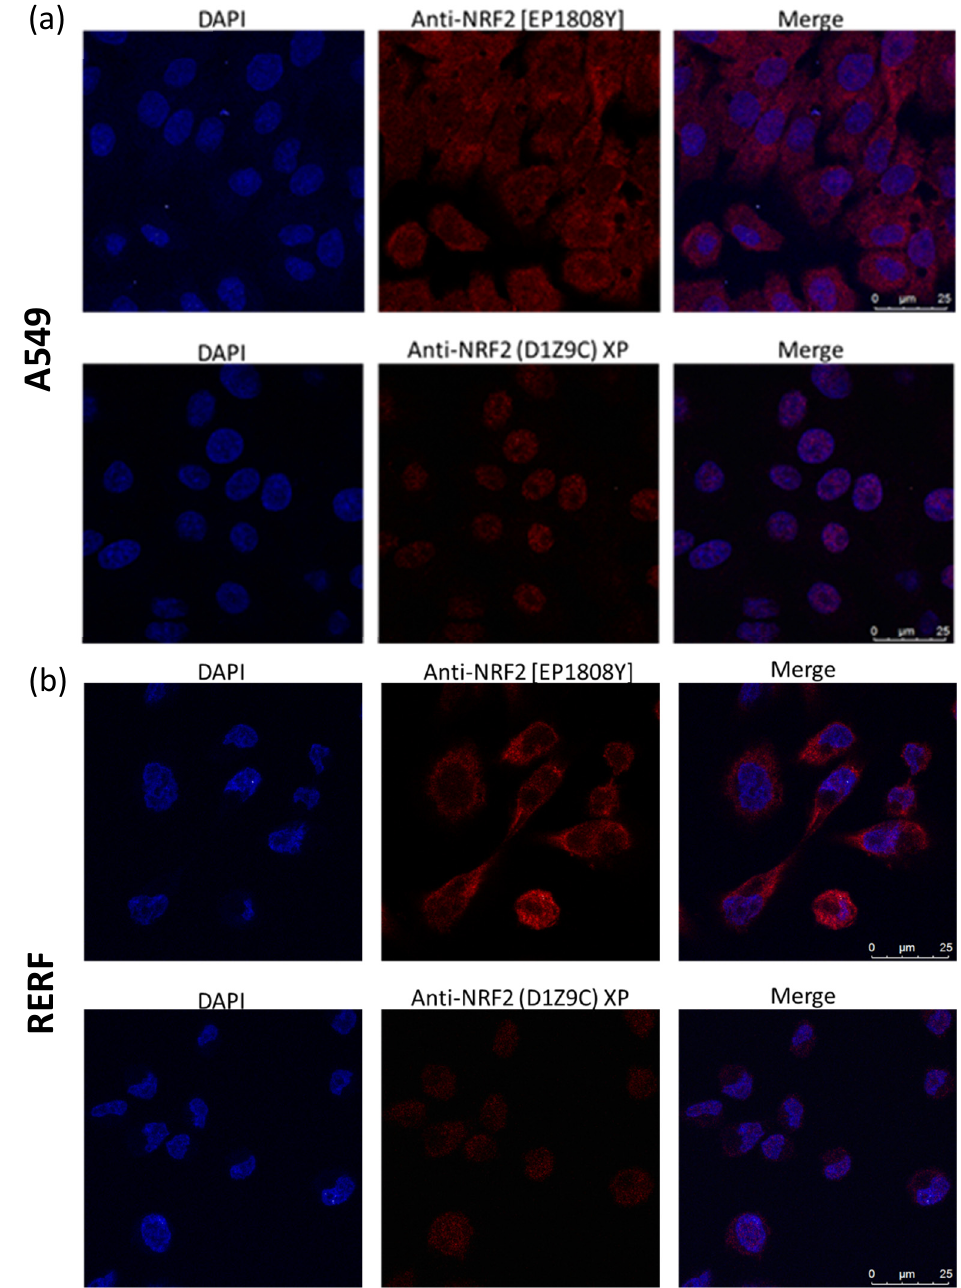
Figure 5. Cellular Nrf2 localization detected with Nrf2-specific monoclonal antibodies EP1808Y and D1Z9C in A549 ( a ) and RERF ( b ) cells. After fixation, cells were stained with Abcam (EP1808Y) and Cell Signaling (D1Z9C) antibodies followed by Alexa Fluor 488 goat anti-rabbit secondary antibodies. Nuclei were stained with DAPI.